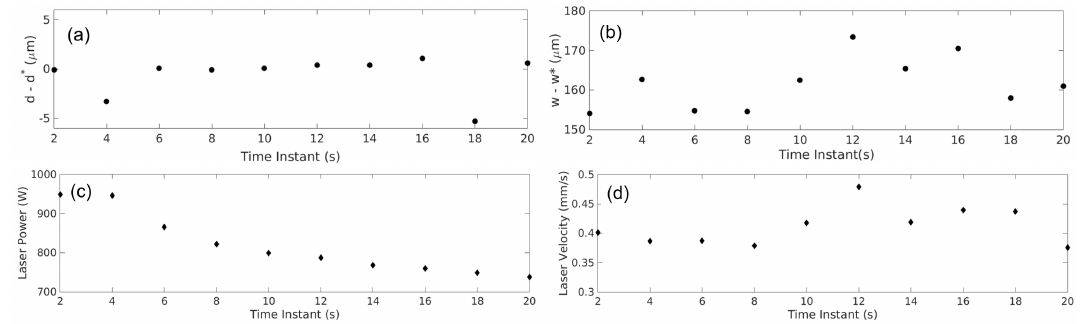
Figure 12. Time-varying control of process parameters at intervals of 2 s for maintaining d ∗ = 2.5 mm and w ∗ = 5.0 mm: ( a ) variation in melt pool depth ( d − d ∗ ) at the control steps, ( b ) variation in melt pool width ( w − w ∗ ) at the control steps, ( c ) optimal laser power, and ( d ) optimal laser